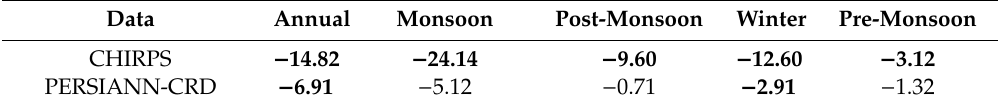
Table 7. Annual and seasonal rainfall trends in the Bhilangana river basin (mm / decade, 1983–2008).